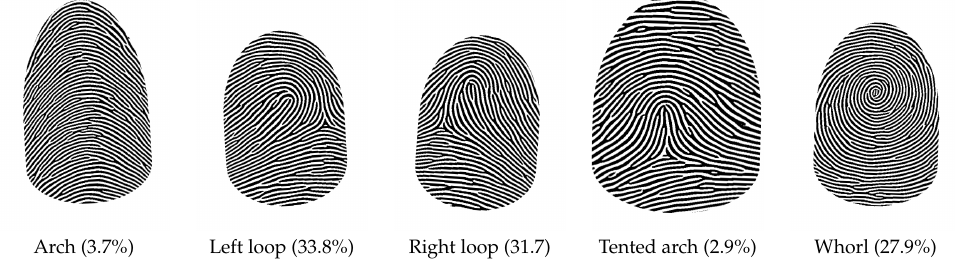
Figure 1. Fingerprint image samples generated, which represent the five fingerprint categories along with their frequency of occurrence in the total